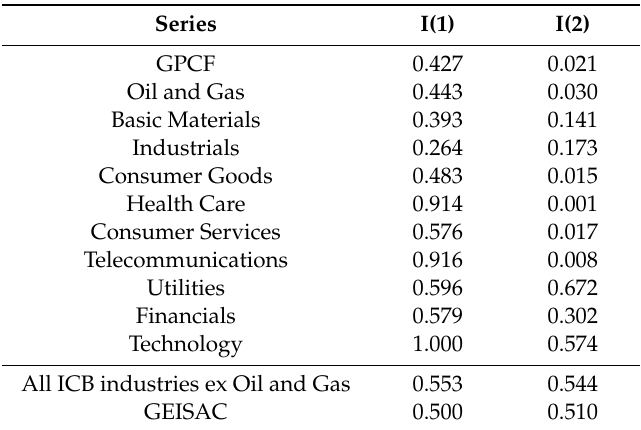
Table 6. p values from Dickey-Fuller tests of the GPCF and each of the weighted operating cash flow series for the major ICB industries.